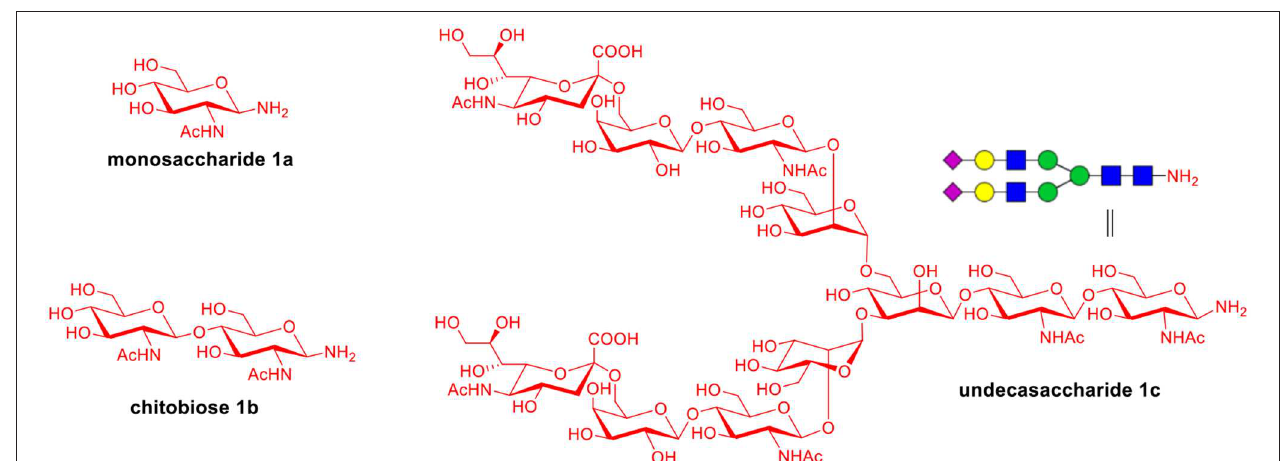
FIGURE 2 | Solid-phase synthesis of peptidyl selenoesters 4b-12b .